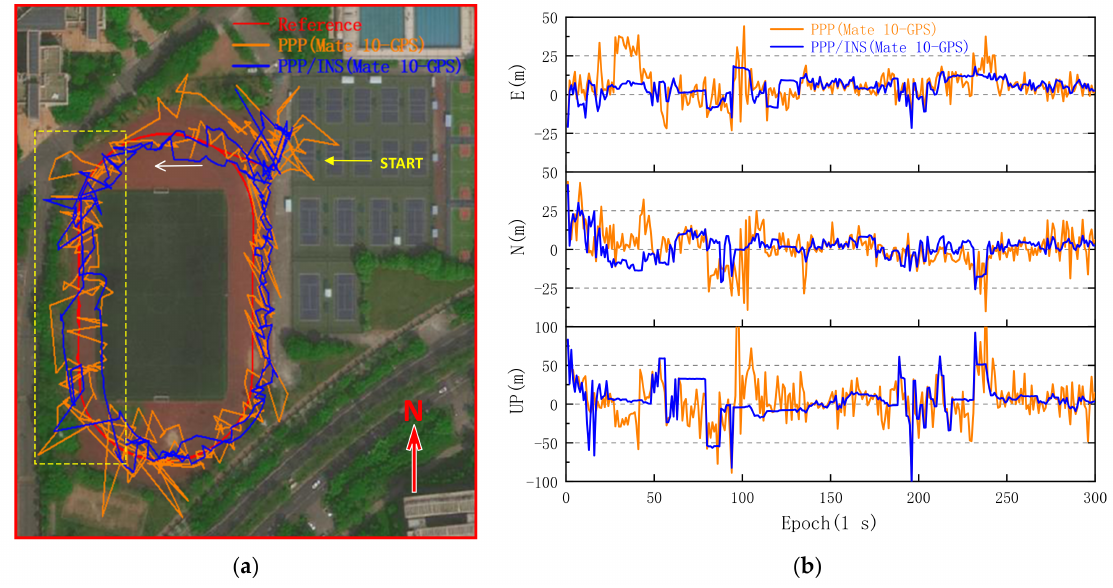
Figure 11. GPS PPP and PPP/INS solutions from Huawei Mate 10 on the playground. ( a ) Trajectories of GPS PPP and PPP/INS solutions. ( b ) Comparison of GPS PPP and PPP/INS solutions with reference points. The E and N denote east and north direction,